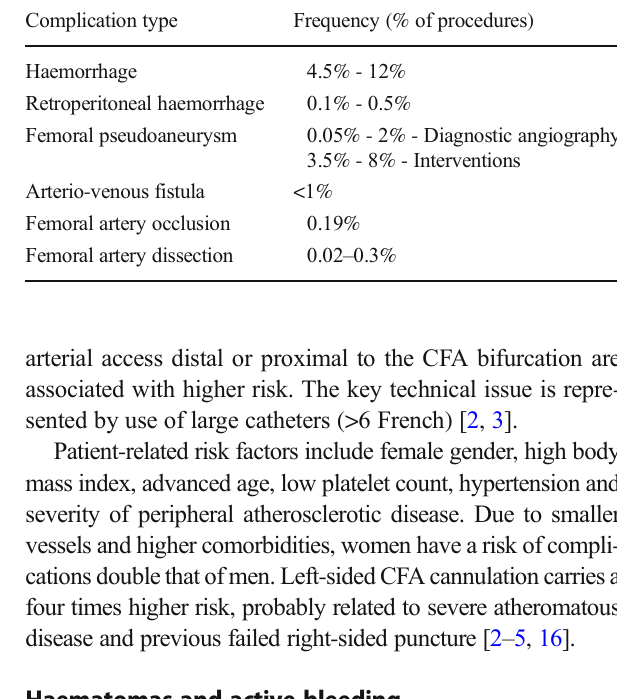
Vascular complications of femoral arterial access (in descending order of frequency) Complication